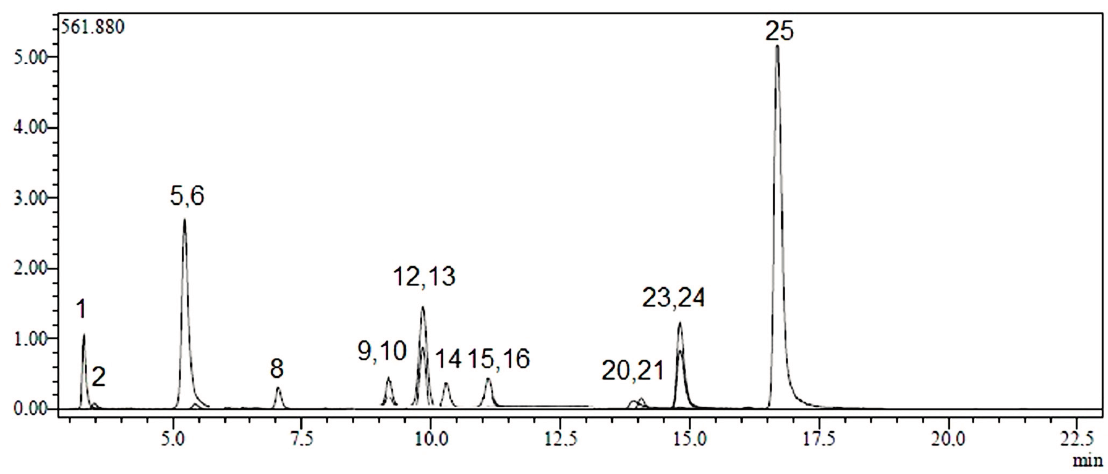
Figure 3. LC-MS/MS chromatograms of AK. Notes: Chromatographic conditions were given in the Experimental Section.